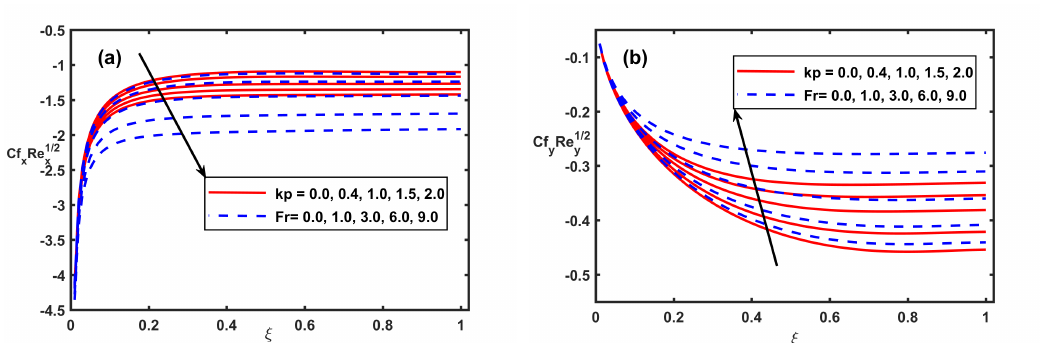
Figure 8. Fluctuation of ˜ φ ( ξ , η ) along with EE , Ω , Nt, and Nb.